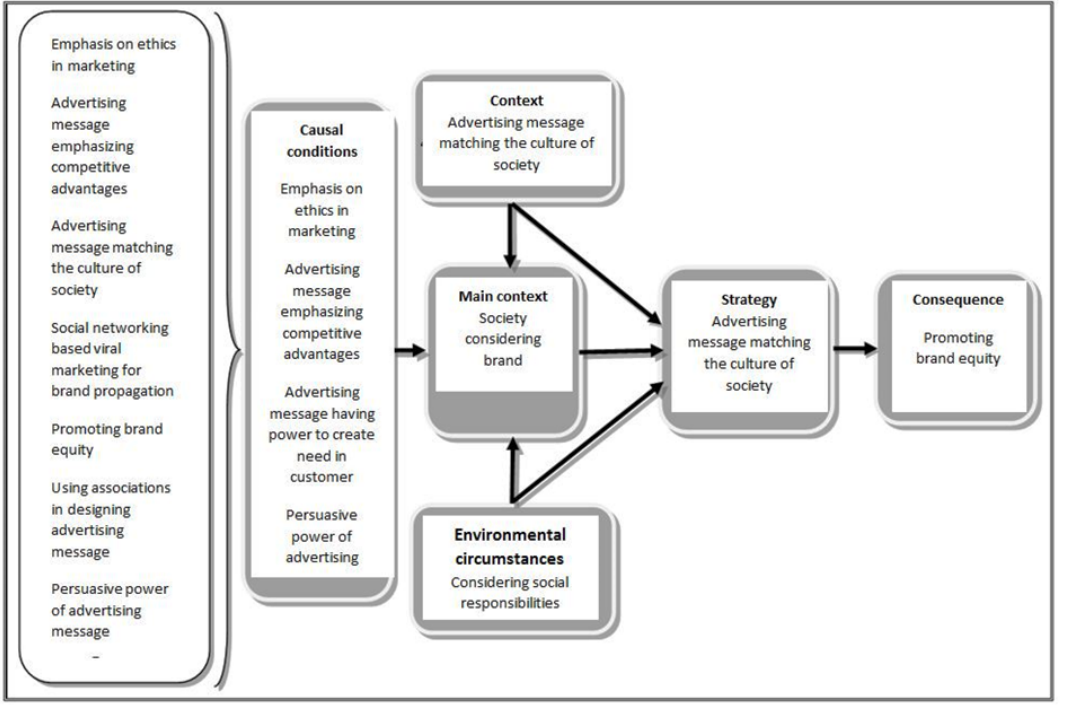
Fig. 4. Transposition of categories in the paradigm model’s